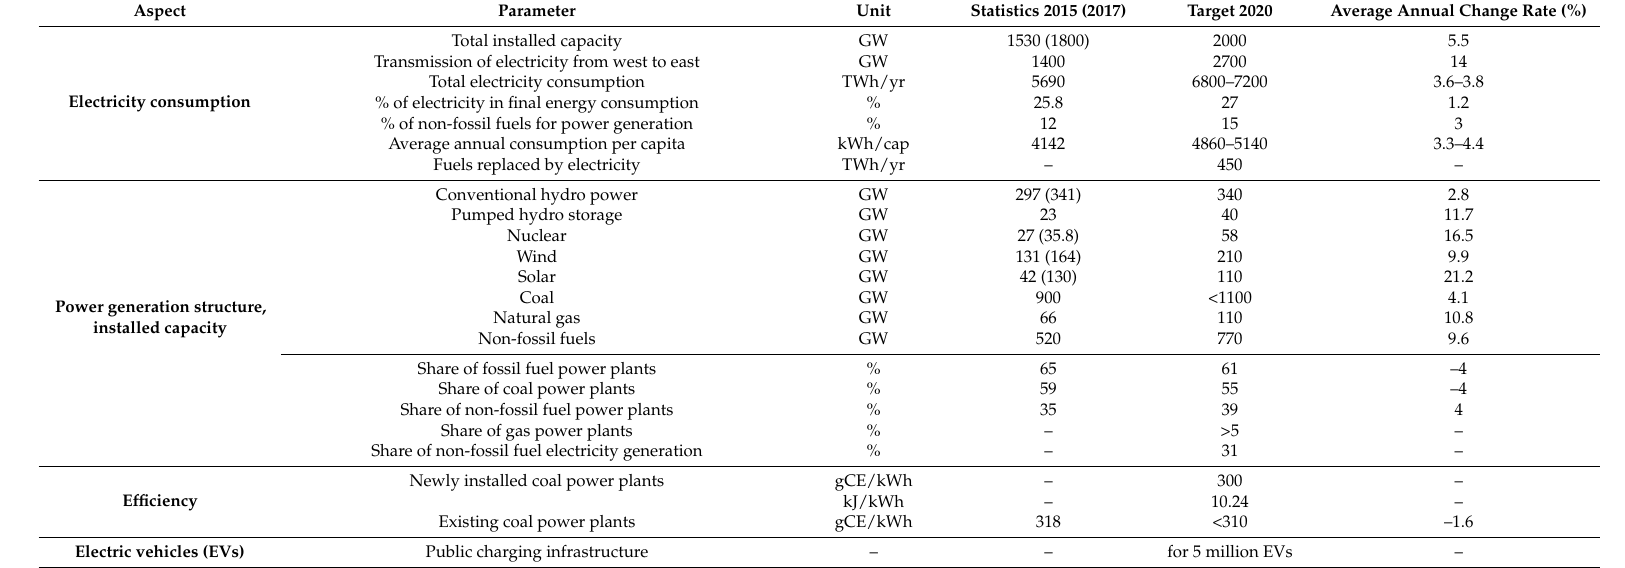
Table 3. Key national energy targets by 2020